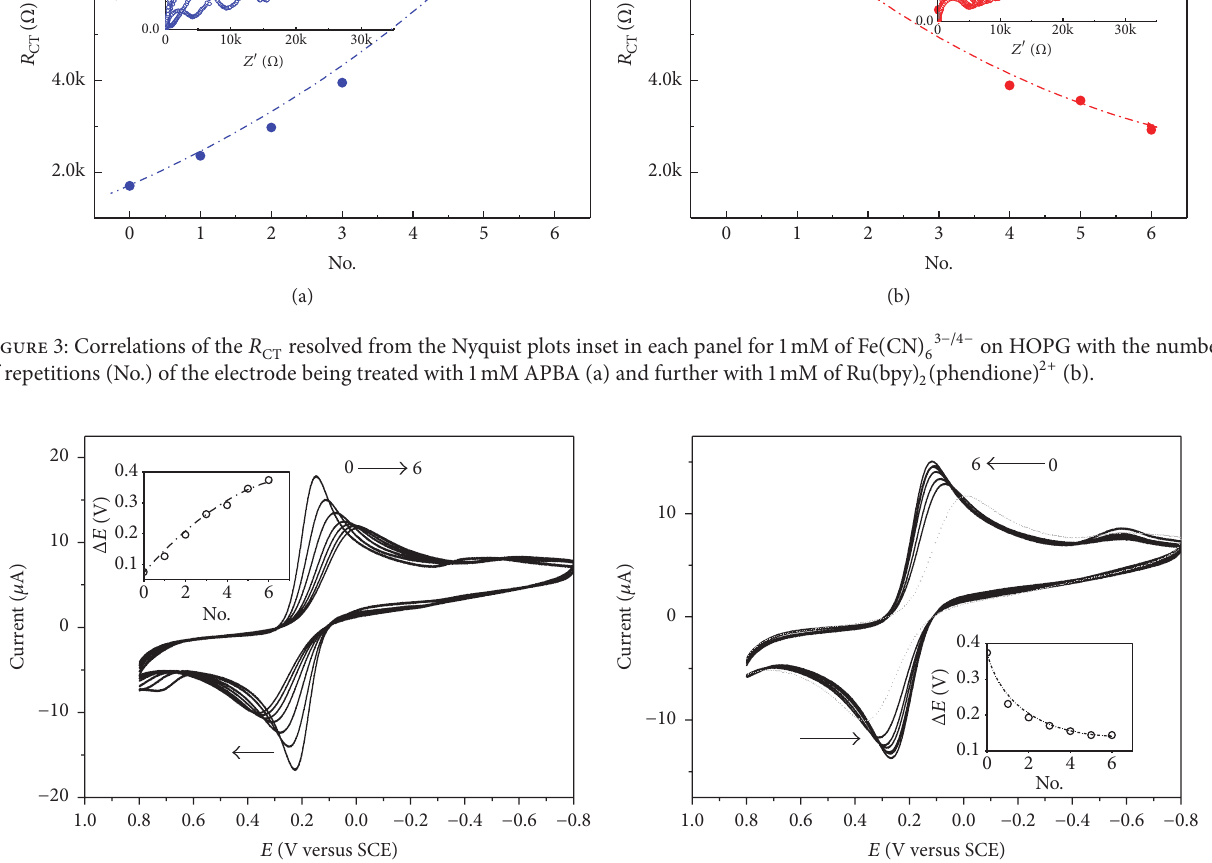
Figure 4: In situ CVs recorded during the EIS measurements as in Figure 3. Insets show that the values of the peak separation ( Δ𝐸 ) are functions of the number of the electrode being treated with 1mM APBA (a) and further with 1mM of Ru(bpy) 2 (phendione) 2+